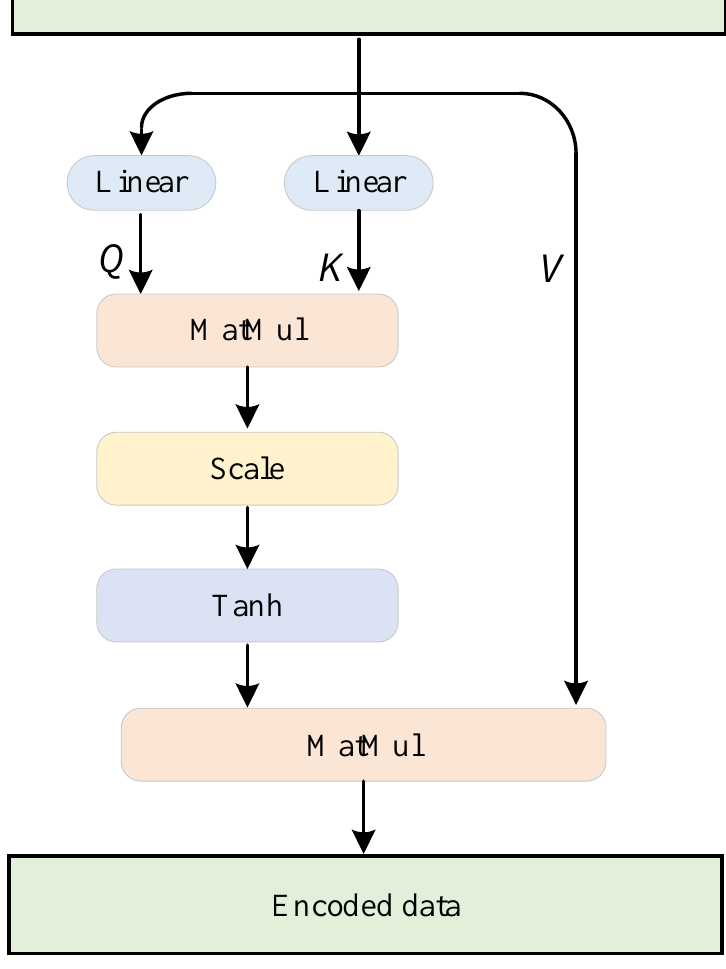
Figure 7. Structure of the encoder.